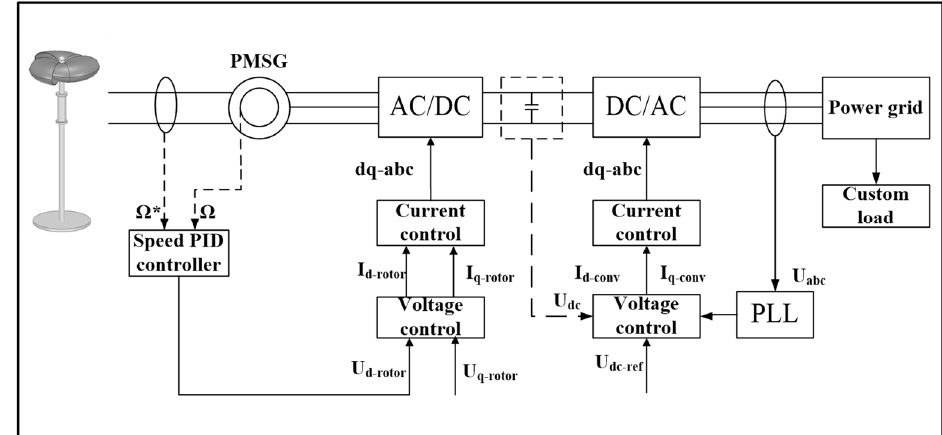
Figure 17. System block diagram.